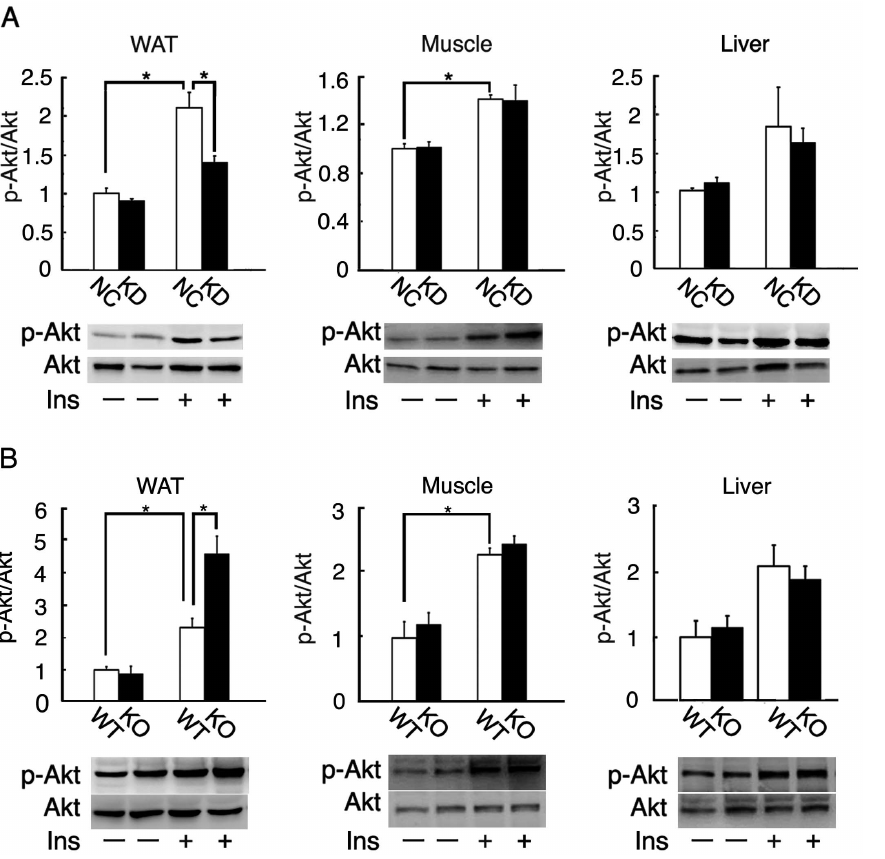
Figure 7. Insulin-stimulated Akt phosphorylation of wild-type and Fgf21 knockout mice. (A) Basal or insulin-stimulated Akt phosphorylation in the subcutaneous white adipose tissue, gastrocnemius muscle, and liver of 3-month-old wild-type mice fed NC or KD for 6 days (n=7 per group; *, P , 0.05). (B) Basal or insulin-stimulated Akt phosphorylation in the subcutaneous white adipose tissue, gastrocnemius muscle, and liver of 3-month-old wild-type (WT) and Fgf21 knockout (KO) mice fed KD for 6 days (n=7 per group; *, P , 0.05). Akt and the phosphorylated form were detected by Western blotting with specific antibodies.